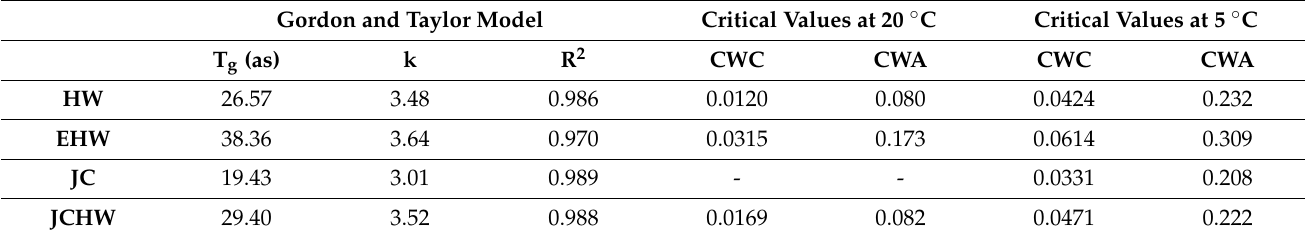
Table 2. Gordon and Taylor model parameters and critical values of water activity and water content (g water/g product) related to glass transition at 5 and 20 ◦ C. HW: hot water; EHW: extrusion + hot water; JC: jet cooker; JCHW: jet cooker + hot water.